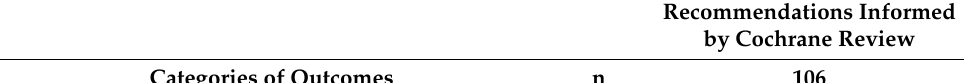
Table 2. Proportions of categories of outcomes informed by Cochrane reviews in Danish National Clinical Guideline development.